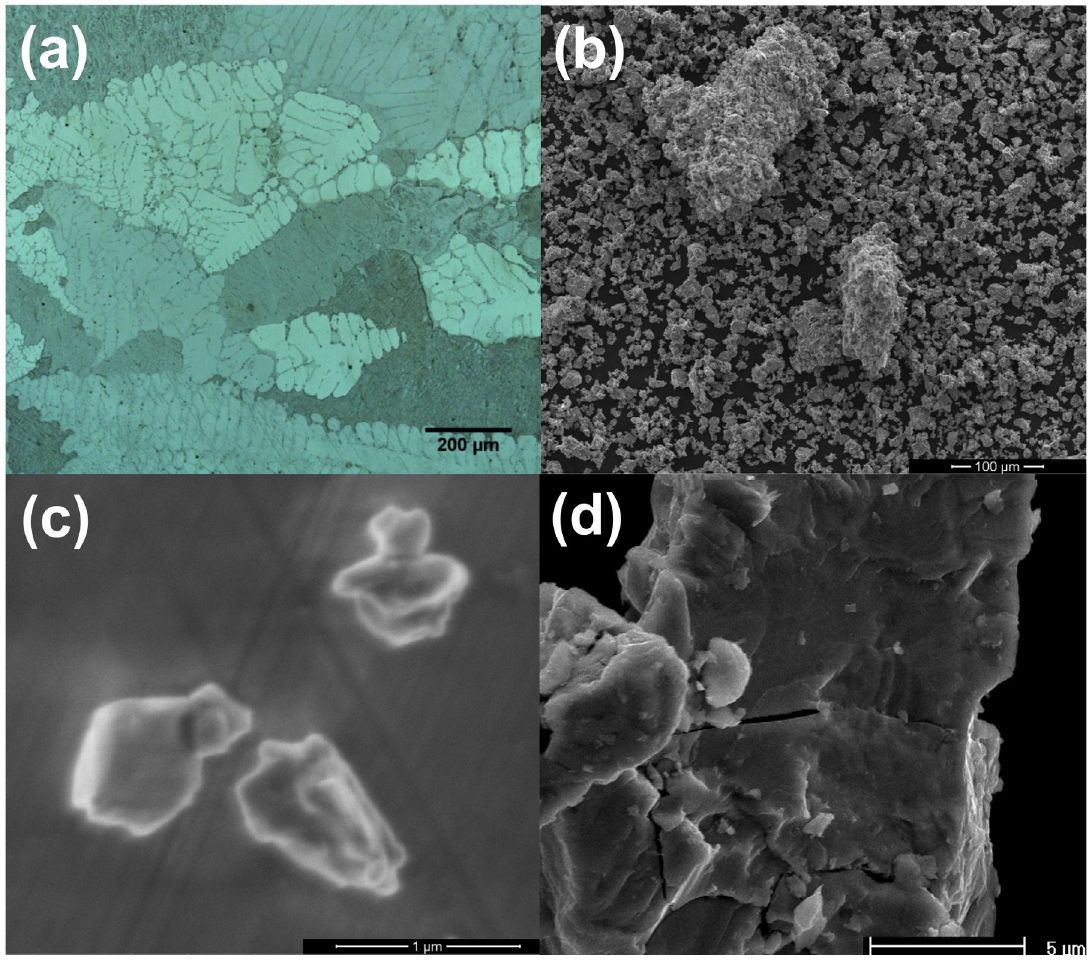
Figure 2. (a) Optical microscopy of the TiFe IMC alloy as-cast (bulk) and (b), (c), and (d) SEM microstructures with magnification of 200x, 100,000x, and 500x, respectively, of the particles formed by cold